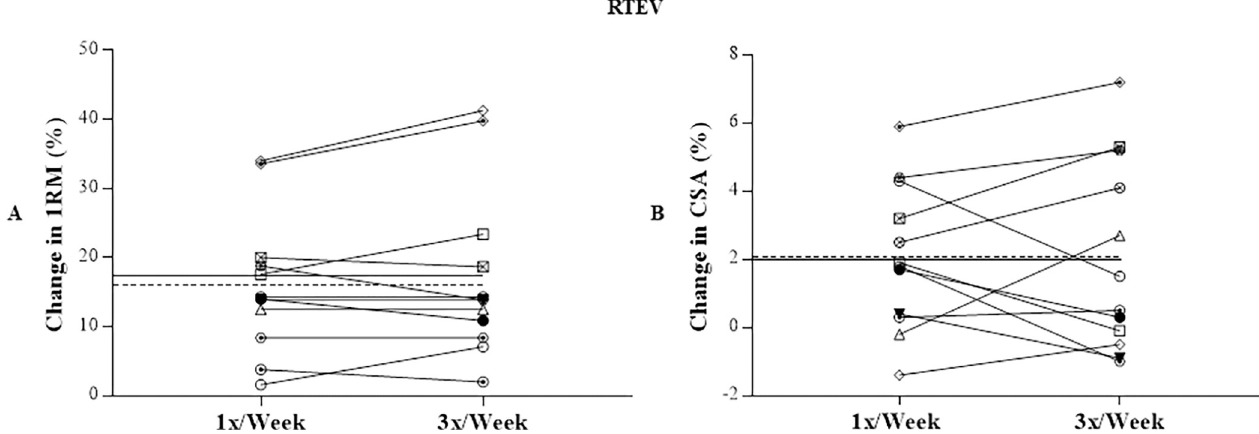
Fig 4. Individual percentage change in the values of 1RM (A) and CSA (B) in the RTEV. 1RM, maximum dynamic strength; CSA, quadriceps femoris cross- sectional area; RTEV, resistance training with equalized total training volume; ———, average of the percentage change 1x/week;–––––, average of the percentage 3x/week.